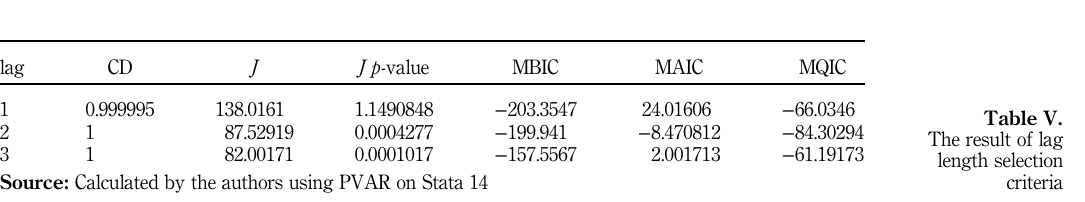
Table IV. Panel unit-root test